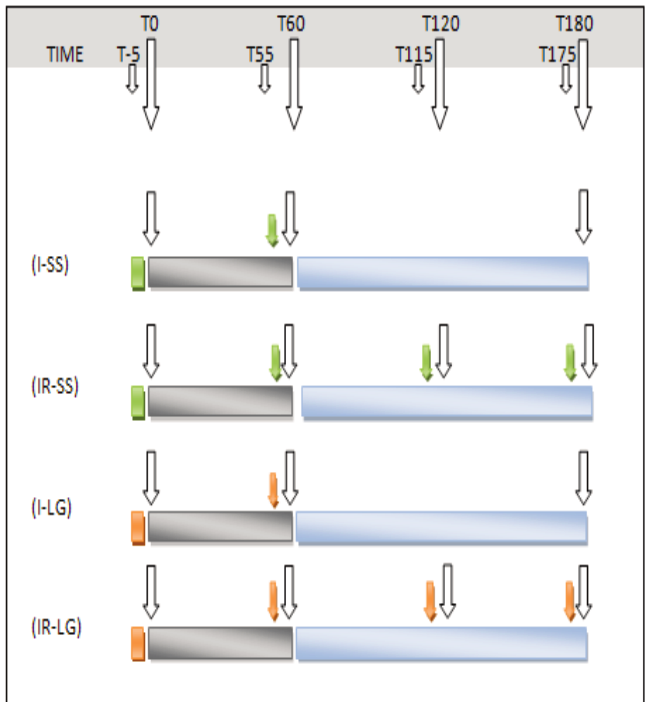
FIGURE 1 - Schematic distribution of the animals in the groups: I-SS (ischemia and saline); IR-SS (ischemia/reperfusion and saline); I-LG (ischemia and L-arginine); IR-LG (ischemia/reperfusion and L-arginine). Periods of drugs administration: T-5 (five minutes before starting ischemia); T0 (starting ischemia); T55 (five minutes before starting reperfusion); T60 (starting reperfusion); T115 (five minutes before the first hour of reperfusion); T175 (five minutes before finishing reperfusion); T180 (finishing the reperfusion). Gray bars (Ischemia); Blue bars (Reperfusion). Green arrow (Saline); Orange arrow (L-arginine). White arrow